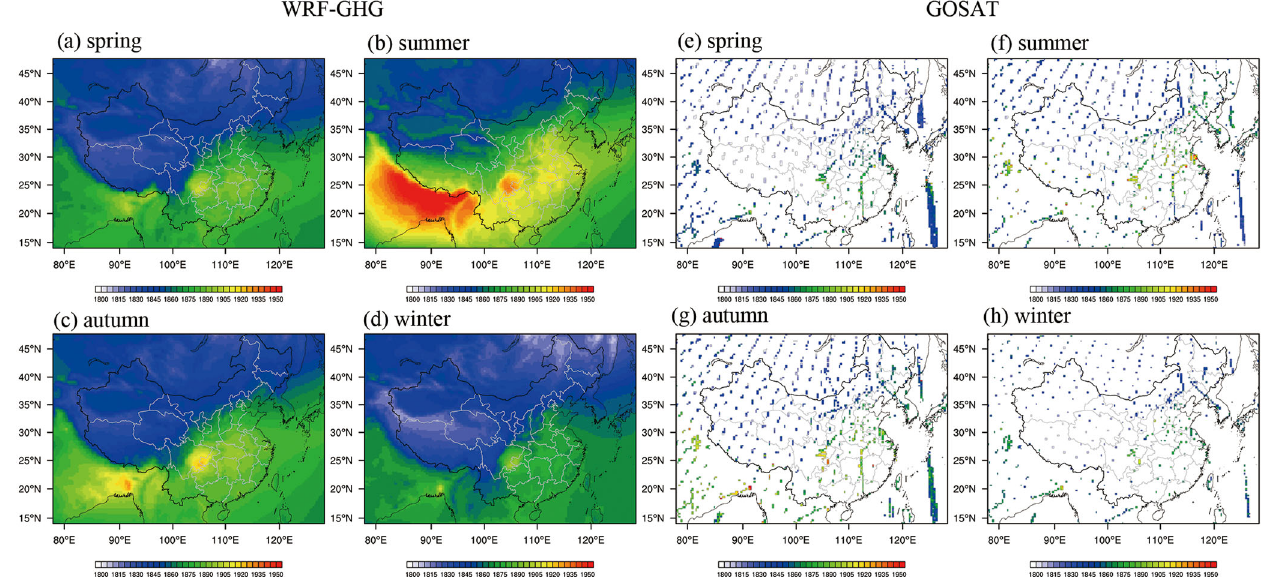
Fig. 1 Model evaluation of CH 4 distribution. Seasonal distributions of dry column mixing ratios of CH 4 (Unit: ppb) from WRF-GHG ( a – d ) and GOSAT ( e – h ) in